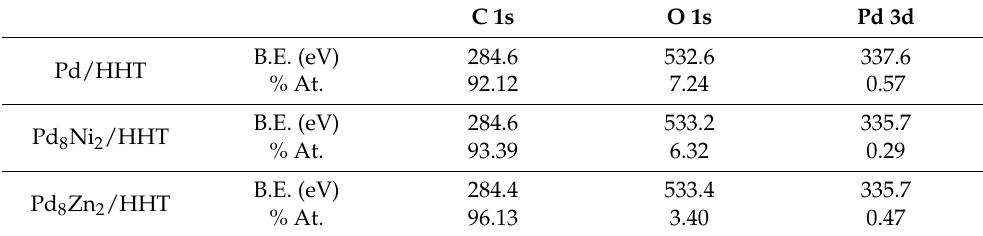
Table 7. Results of the XPS survey spectra.